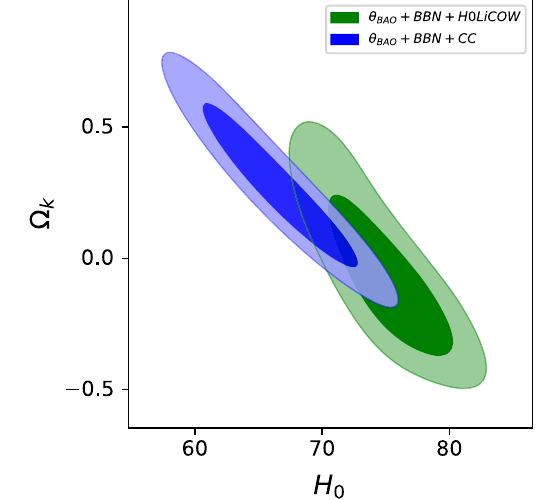
Fig. 3 Left Panel: The 68% CL and 95% CL regions in the H 0 − (cid:3) θ k plane inferred from BAO + BBN analyses in combination with H0LiCOW and CC data. Right Panel: Parametric space in the H 0 − r d